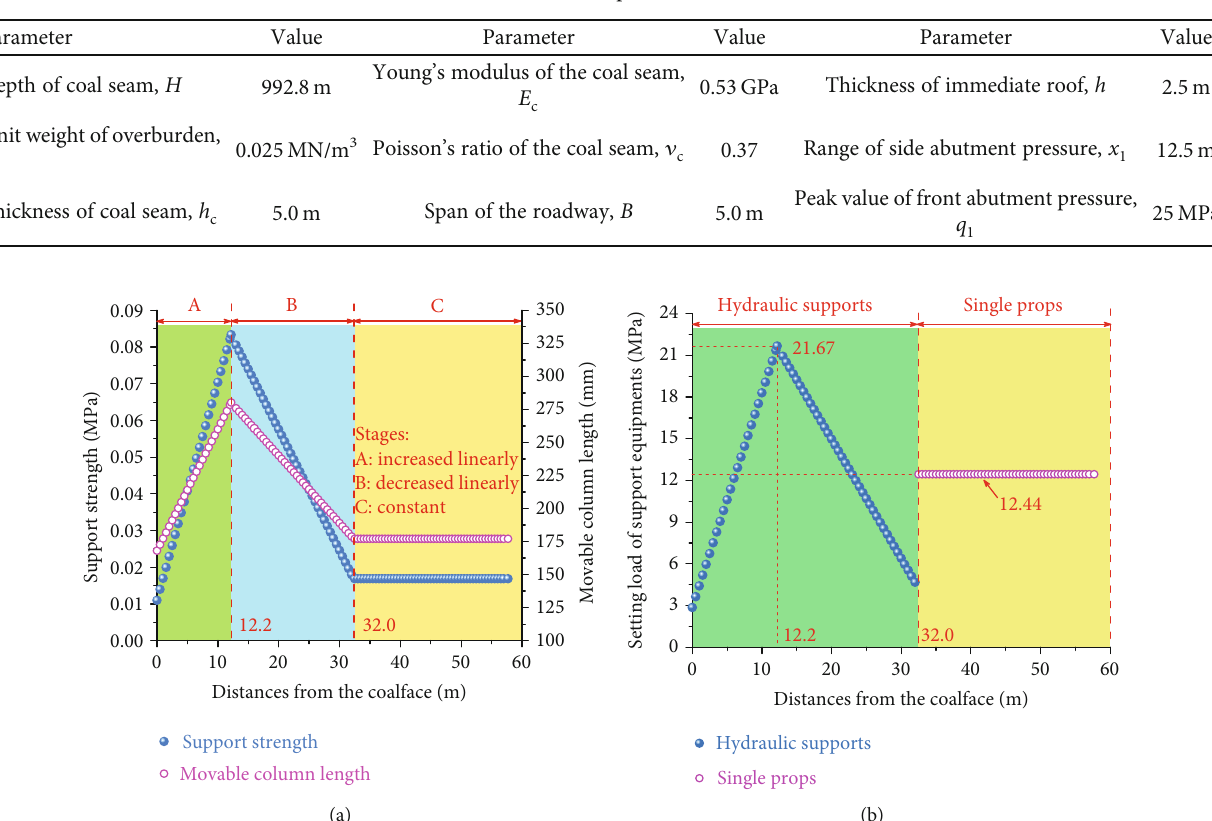
Table 2: Basic parameters.